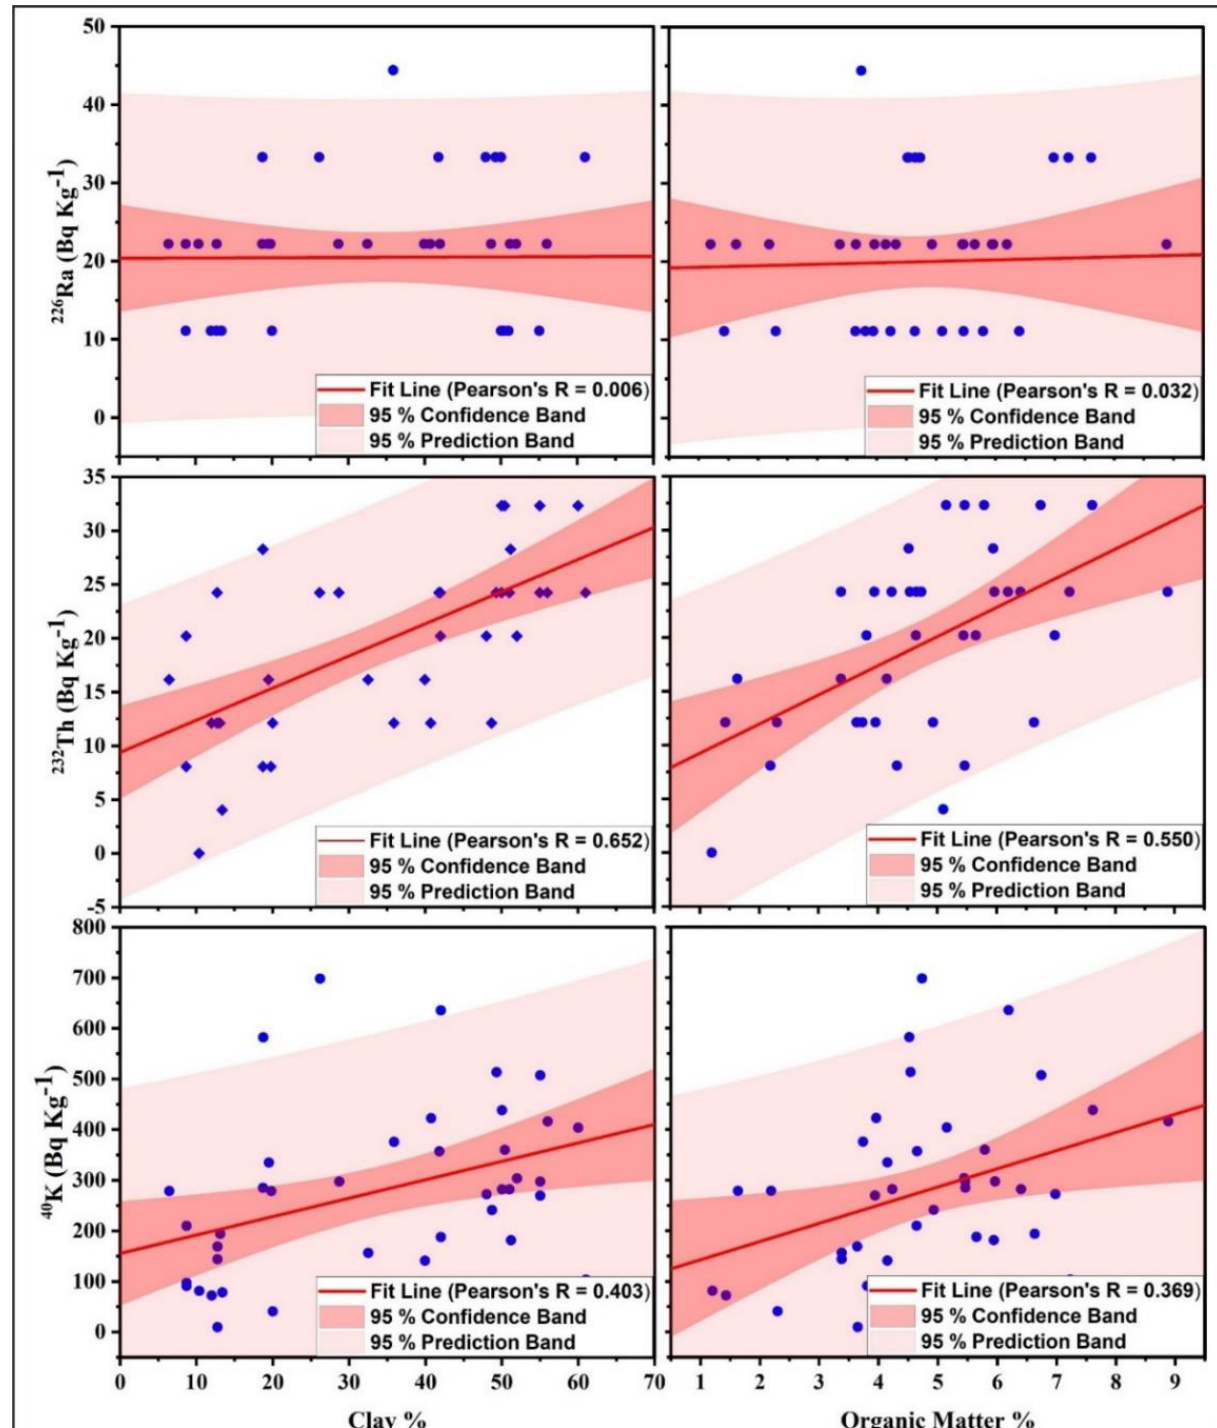
Figure 6. Scatter plots showing the relationships between 226 Ra, 232 Th, and 40 K and the clay and organic matter contents %.